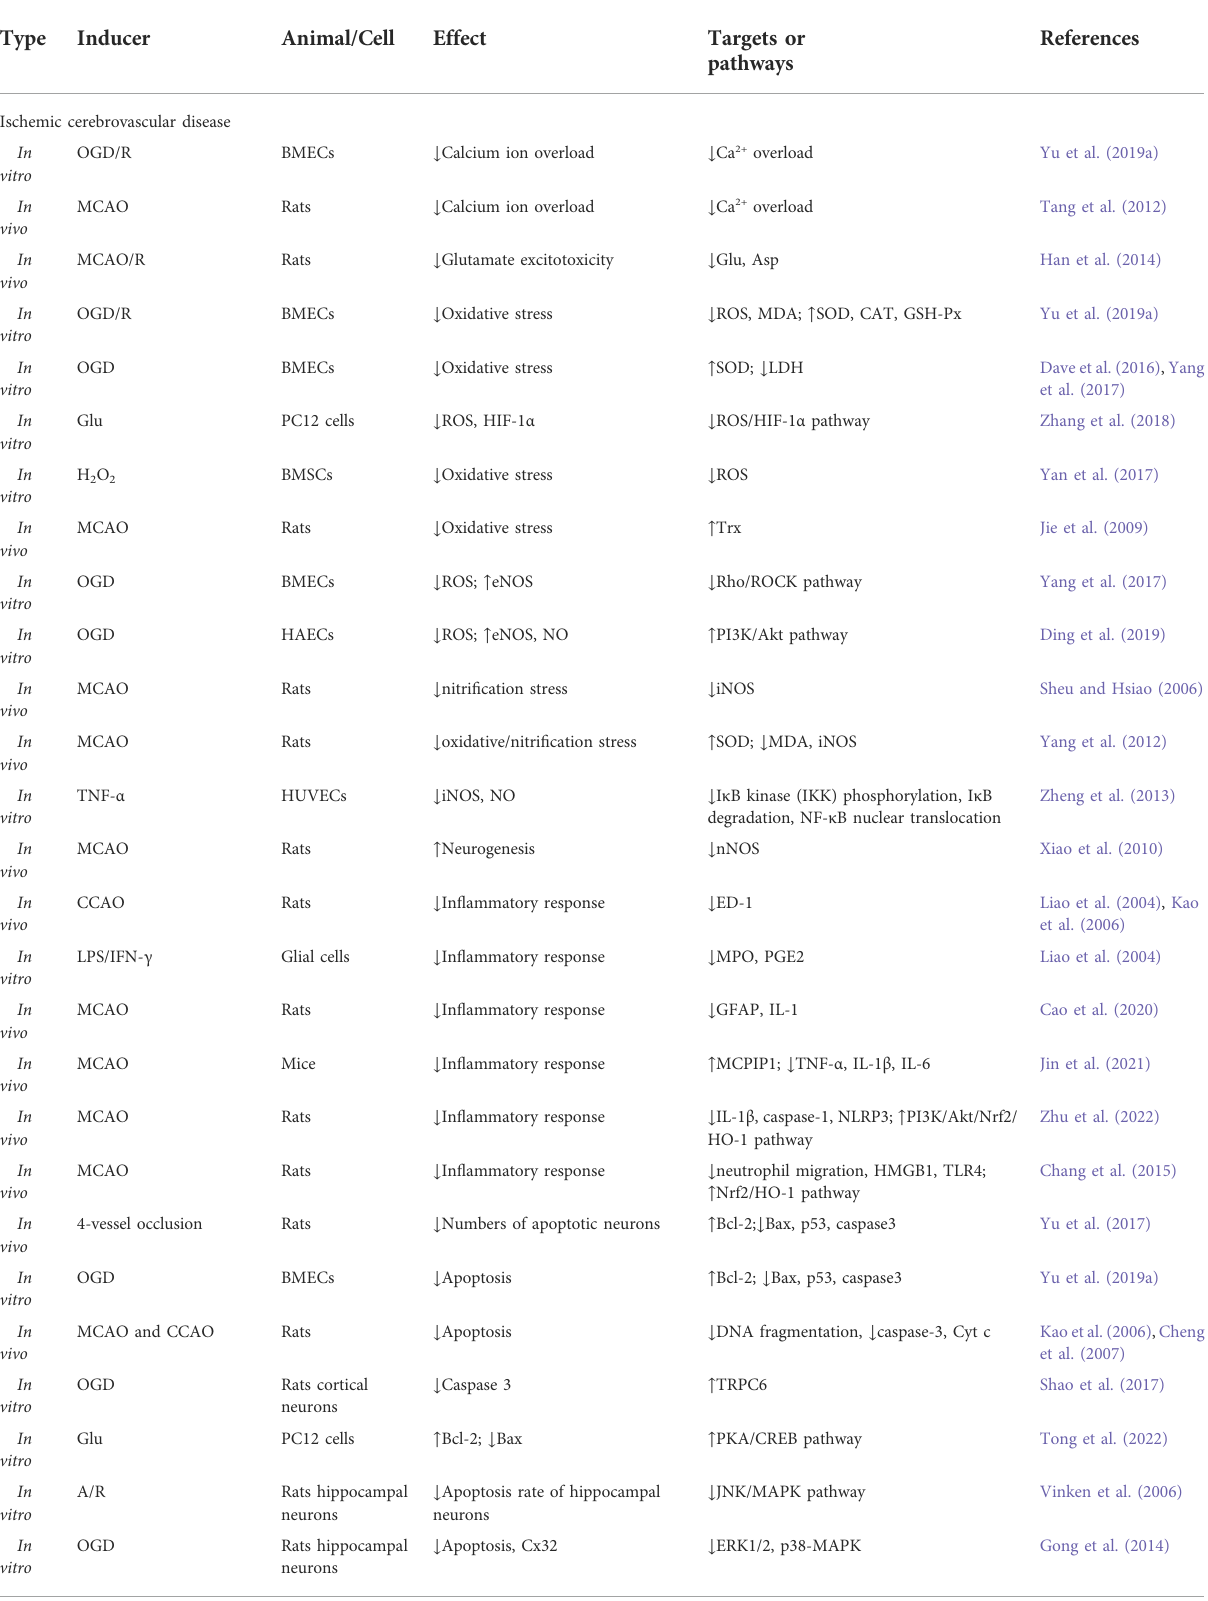
TABLE 1 Effects of TMP in vivo and in vitro studies of CNS